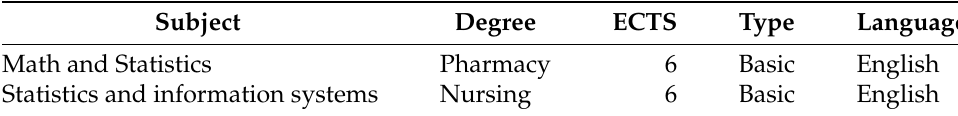
Table 4. Subjects under study.